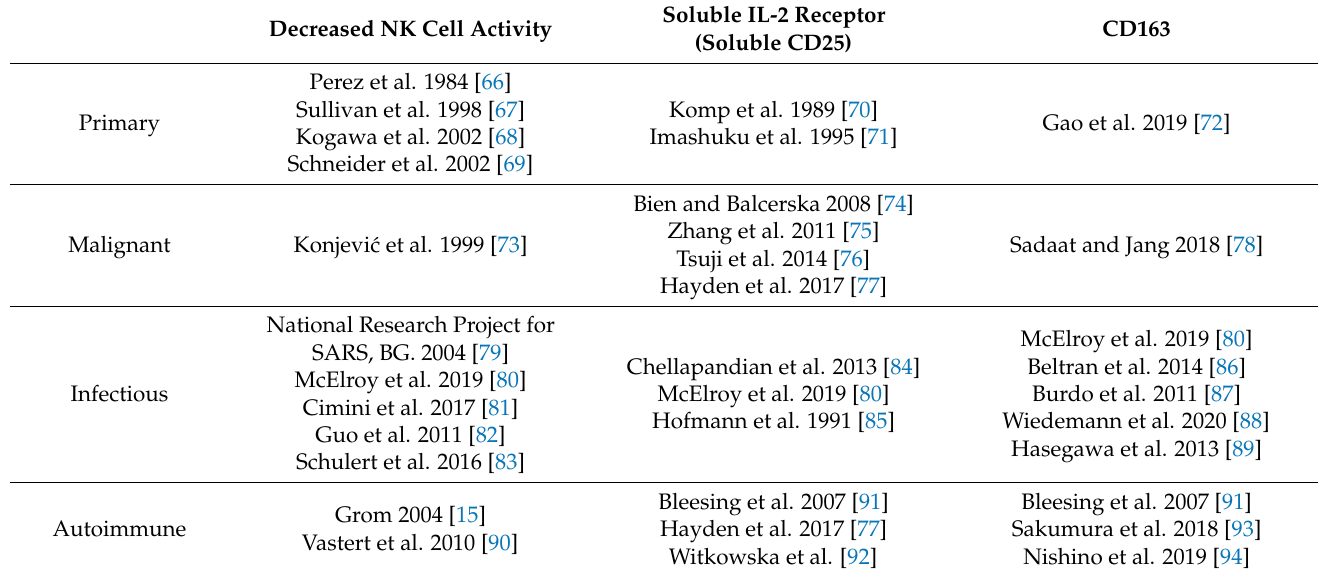
Table 1. Summary of published findings for NK activity, soluble IL-2 receptor and CD163 in primary and secondary causes of